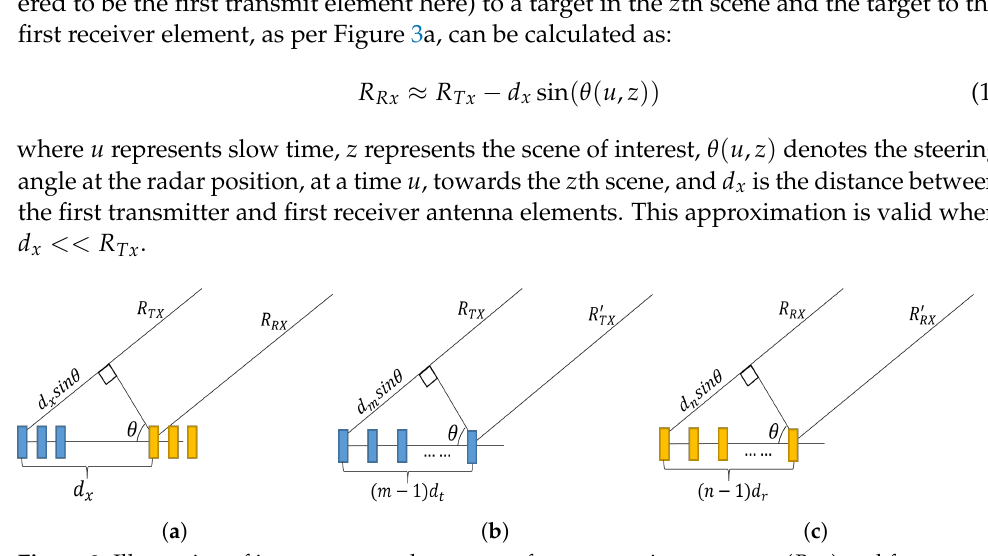
Figure 3. Illustration of instantaneous slant ranges from transmitter to target ( R Tx ) and from